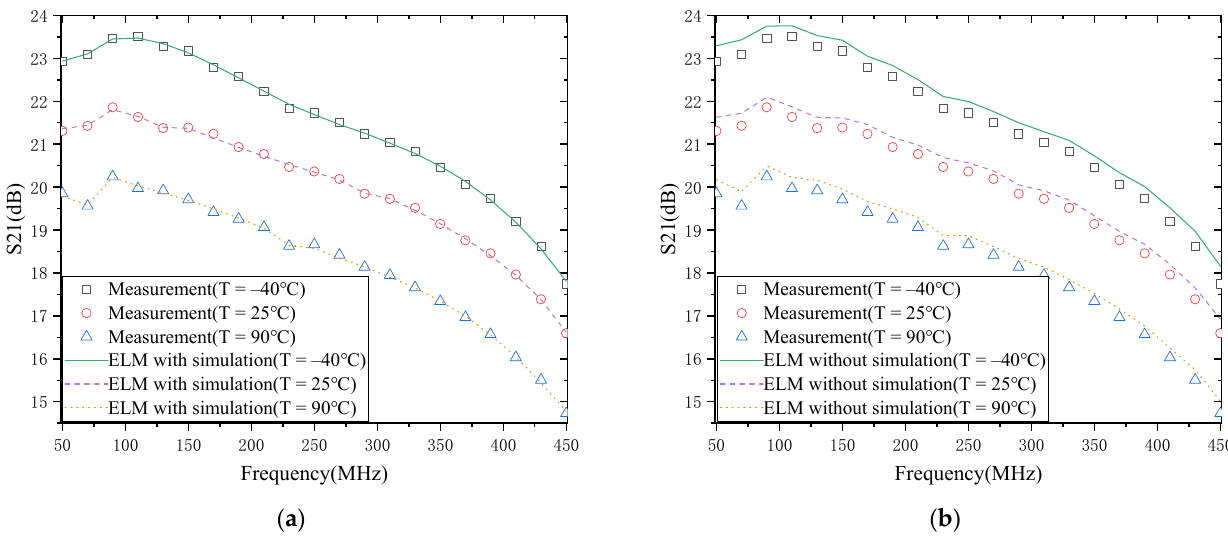
Figure 7. S21 of the LNA: ( a ) with simulation; ( b ) without simulation.